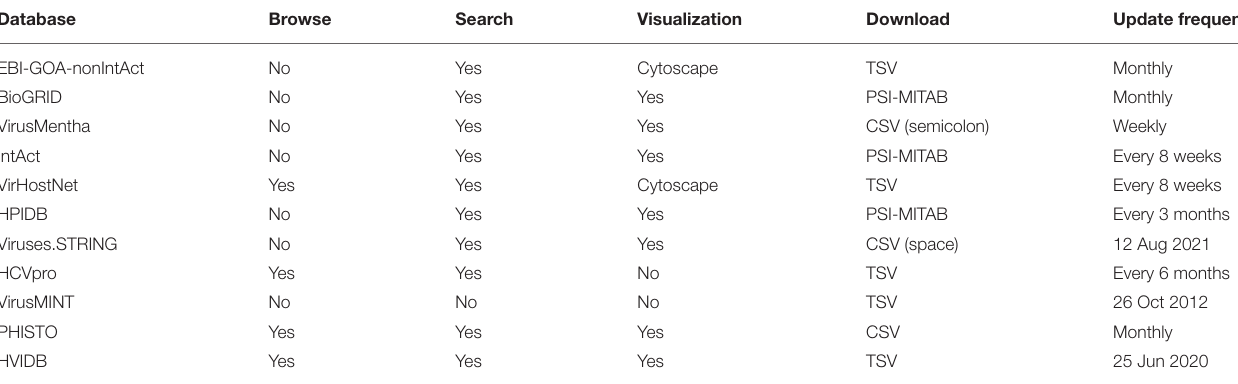
TABLE 2 | Main features of the virus-host protein–protein interaction databases. Database